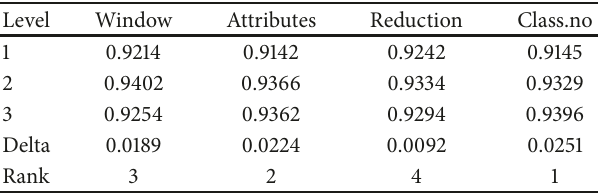
Table 7: Response table for means: Sea